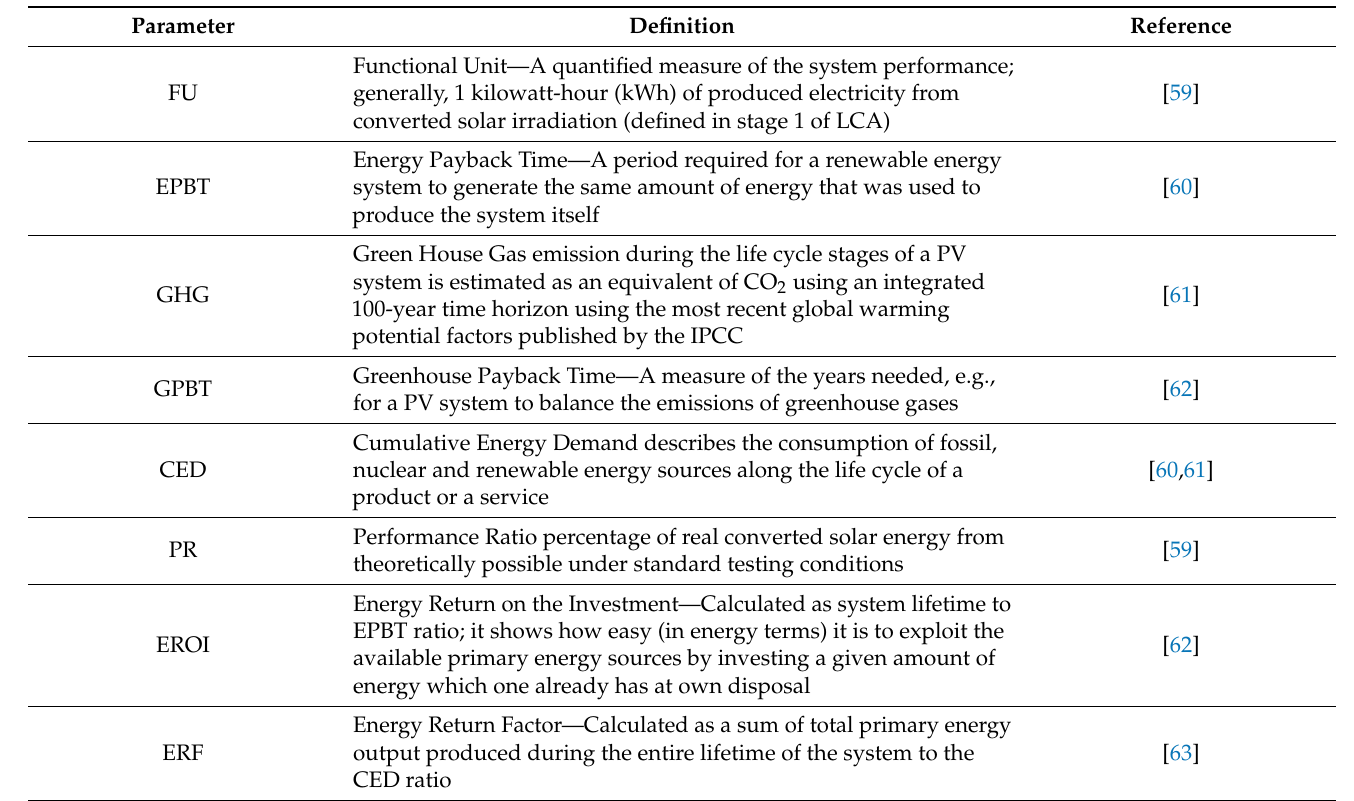
Table 3. Selected coefficient of the environmental impact assessment